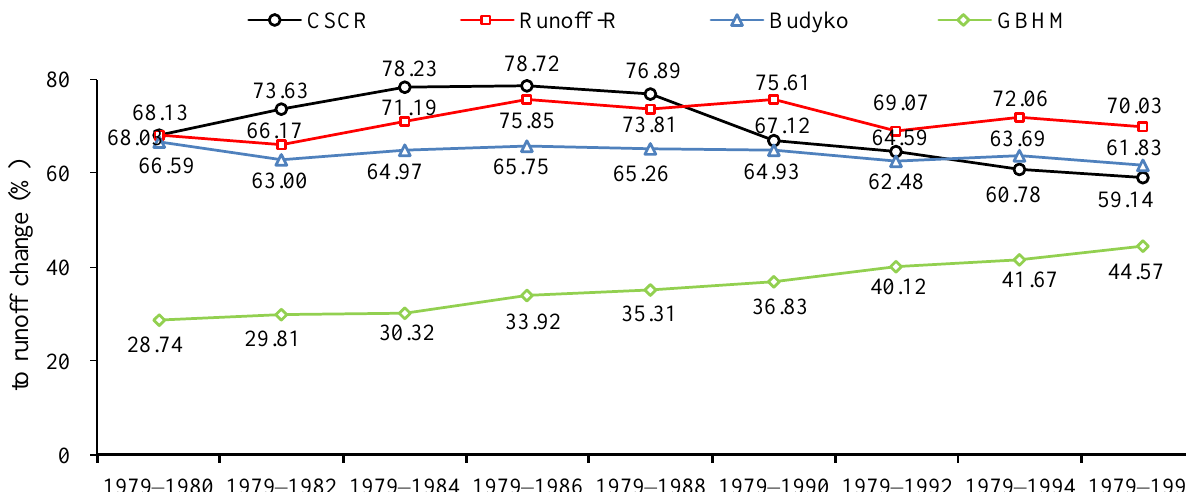
Figure 11. In the change period (2), Uncertainty analysis diagram for the four methods in change period (3) (SCRCQ = slope change rate cumulative quantity; Runoff-R = the runoff reduction method).